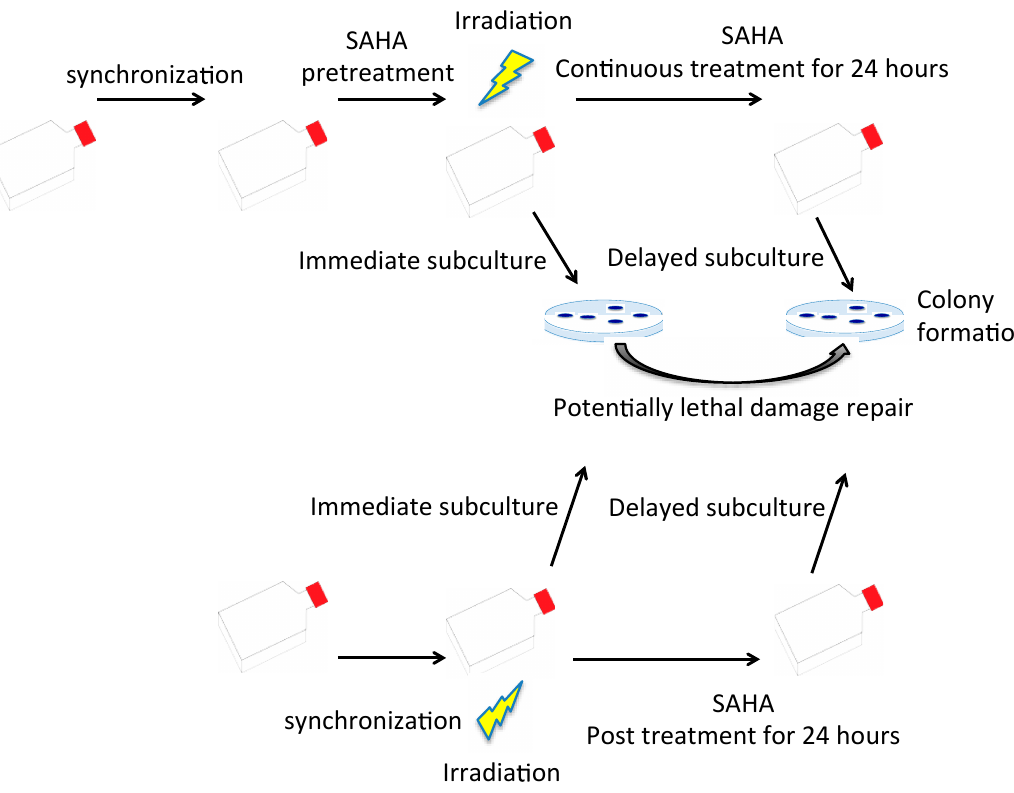
Figure 6. Potentially lethal damage repair analysis with immediate and delayed subculture. Synchronized cells were irradiated with or without SAHA treatment. After irradiation, cells were immediately subcultured for colony formation or delayed subculture after 24 h incubation in the presence of SAHA.